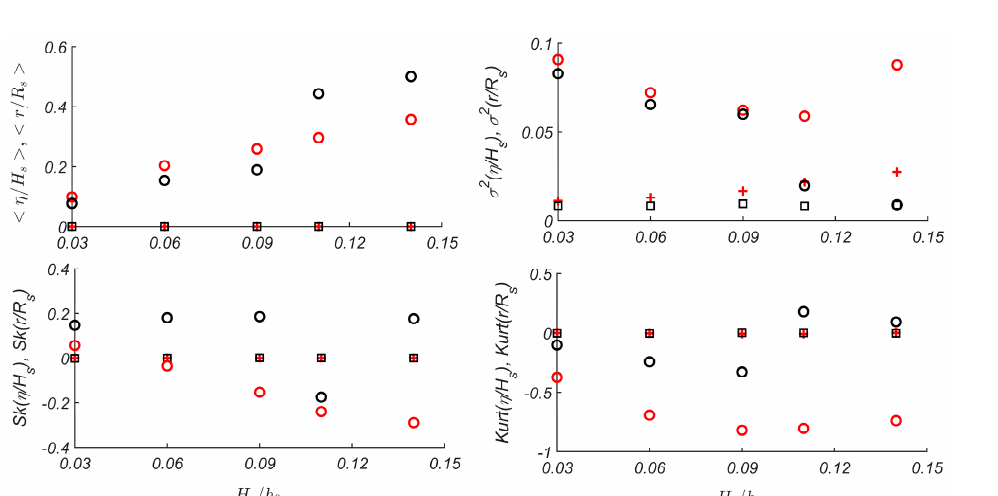
Figure 6. Statistical moments of runup oscillations (normalized by R s ) of narrow-banded (red circles) and wide-banded (black circles) waves on a beach, r , versus nonlinearity, H s / h 0 . Statistical moments of narrow-band and wide-band wave fields o ff shore (normalized by H s ) are shown by red crosses and black squares,